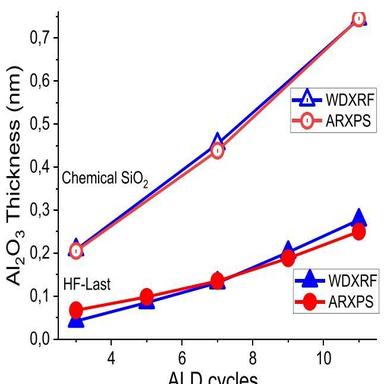
Al2O3 thickness as a function of the number of ALD cycles for chemical SiO2 and HF-last sample preparation as determined by pARXPS (circles) and WDXRF (triangles).